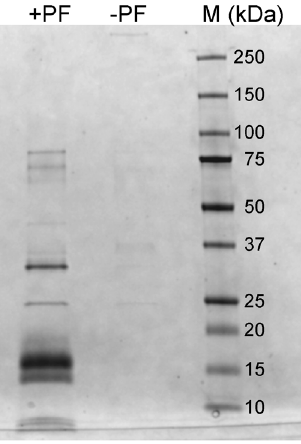
Figure 6. SDS-PAGE showing the separation of protein interaction partners of A b 42 CC protofibrils (PF) extracted from human serum (M = molecular mass markers). The arrow indicates the band corresponding to apolipoprotein E. Essentially no binding is observed in control experiments with glycine-coated beads (-PF). The strong bands around 15 kDa are SDS-stable dimers and trimers